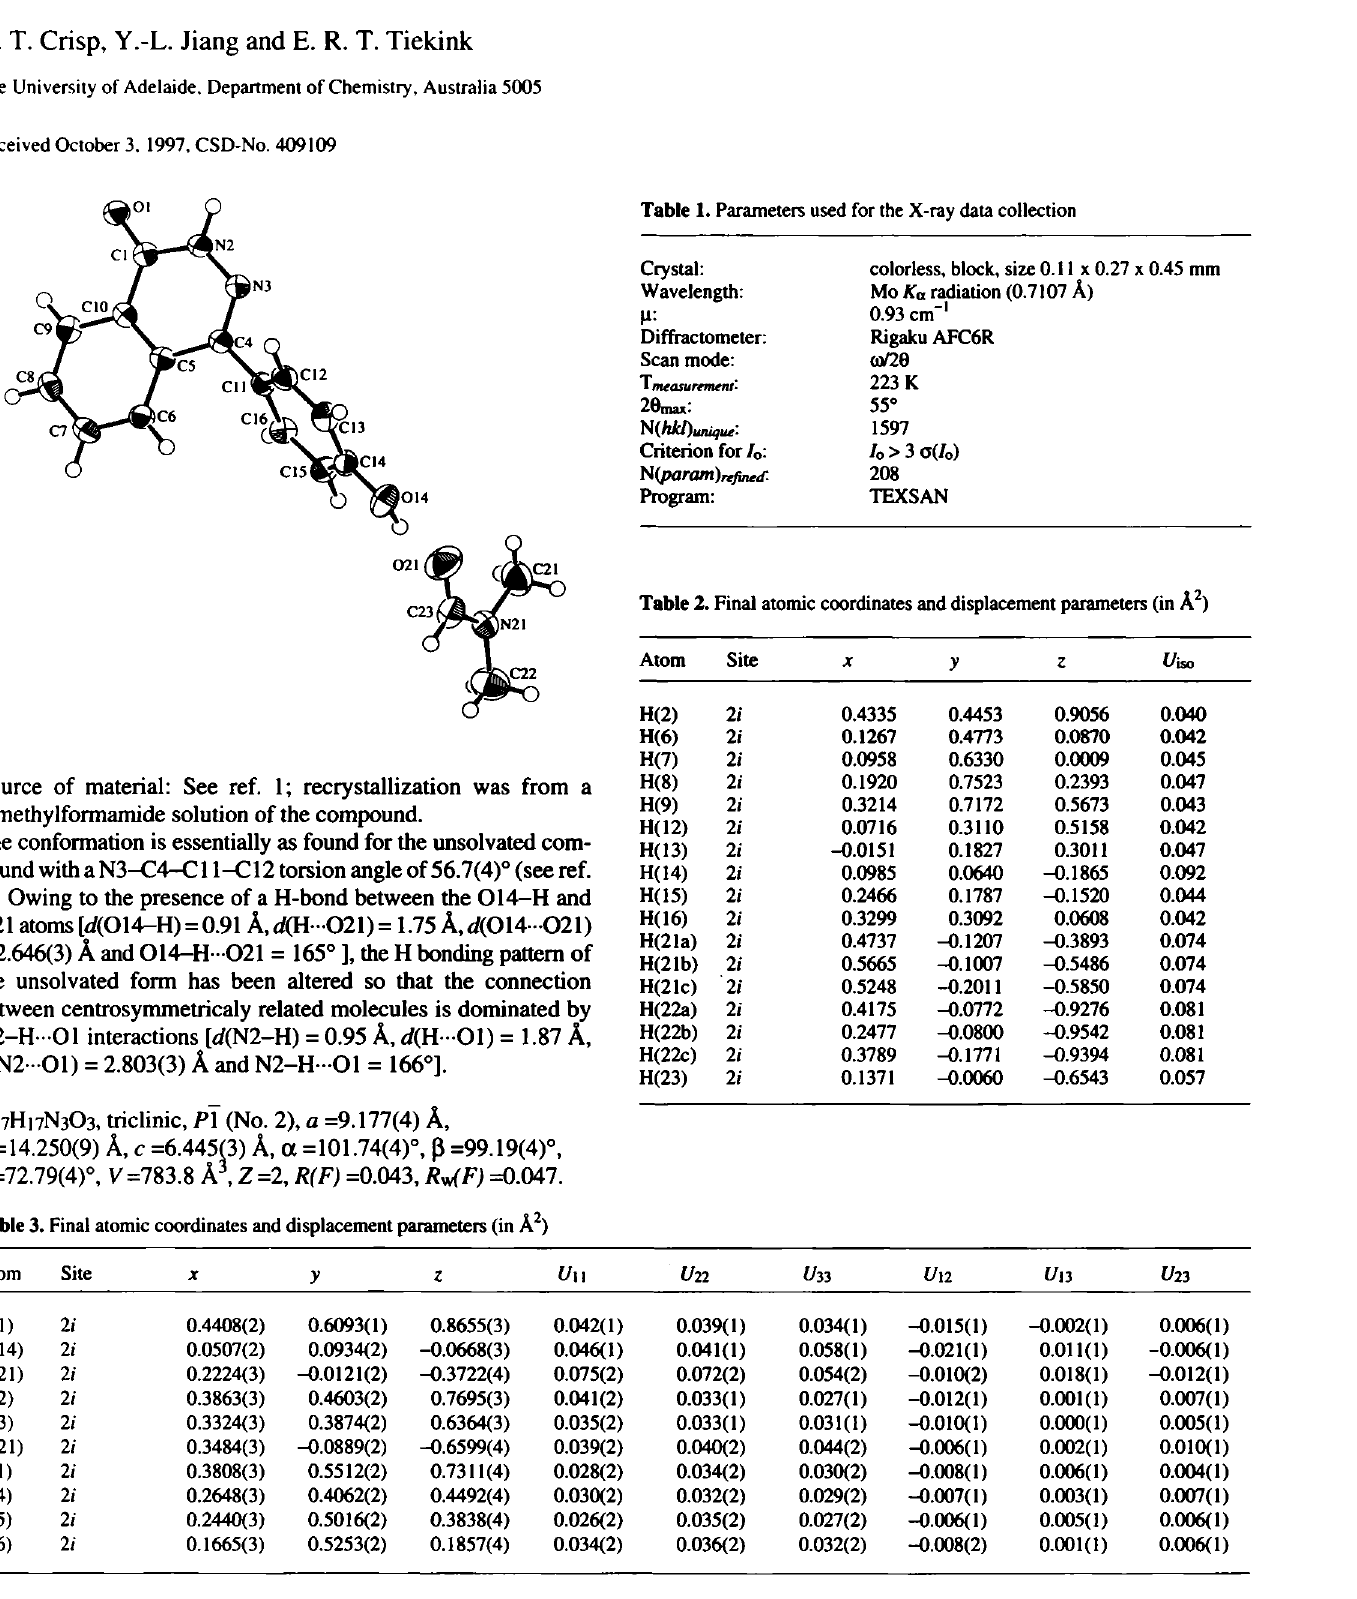
Table 1. ParameteR used for the X-ray data collection